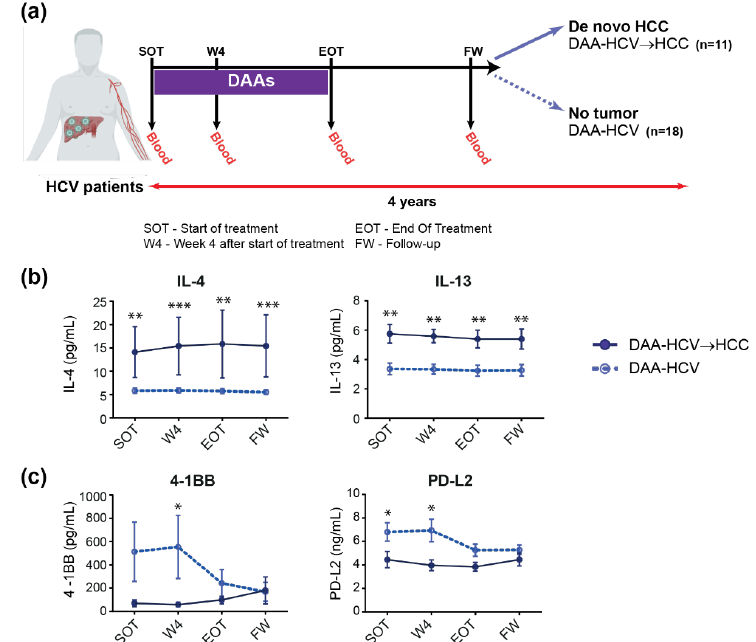
Figure 1. Design of study and circulating levels of immune mediators in hepatitis C virus (HCV)-infected patients treated by direct-acting antiviral (DAA). ( a ) Patients with chronic HCV were treated by DAA and followed up to check for hepatocellular carcinoma (HCC) development over a 4-year period ( n = 334). Samples were collected at start of the treatment (SOT), four weeks after SOT (W4), end of the treatment (EOT), and 3 months after EOT as follow-up (FW). ( b ) Serum levels of interleukin (IL)-4 and IL-13 and ( c ) 4-1BB and programmed death (PD)-L2 in patients who developed de novo HCC following DAA treatment (DAA-HCV → HCC, n = 11) and patients who did not develop HCC (DAA-HCV, n = 18). * p < 0.05; ** p < 0.01; *** p <